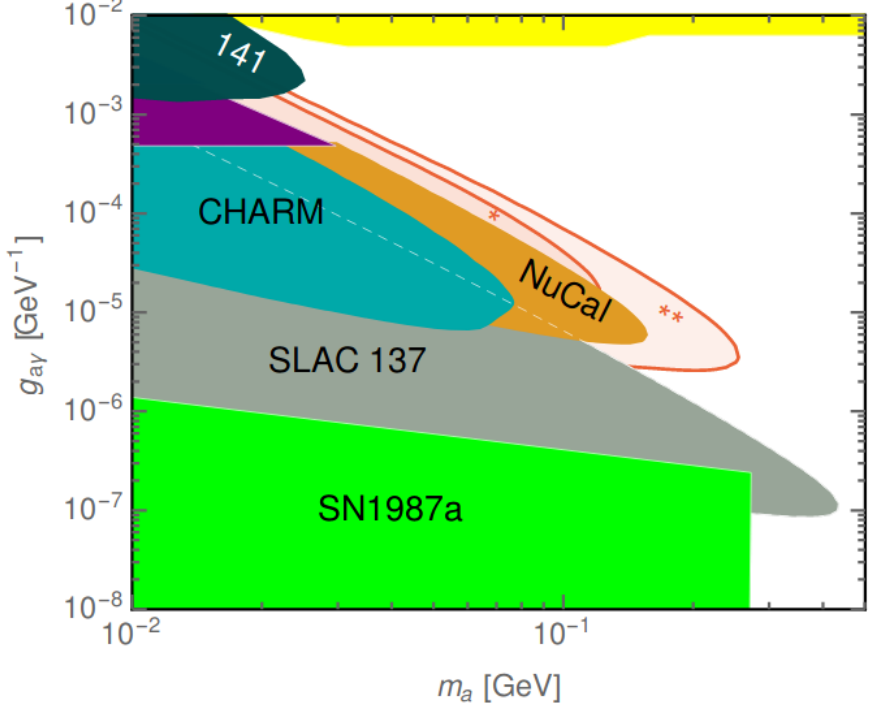
Figure 5. Parameter regions of Figure 4, overlaid with previously performed experiments and astrophysical constraints [11].